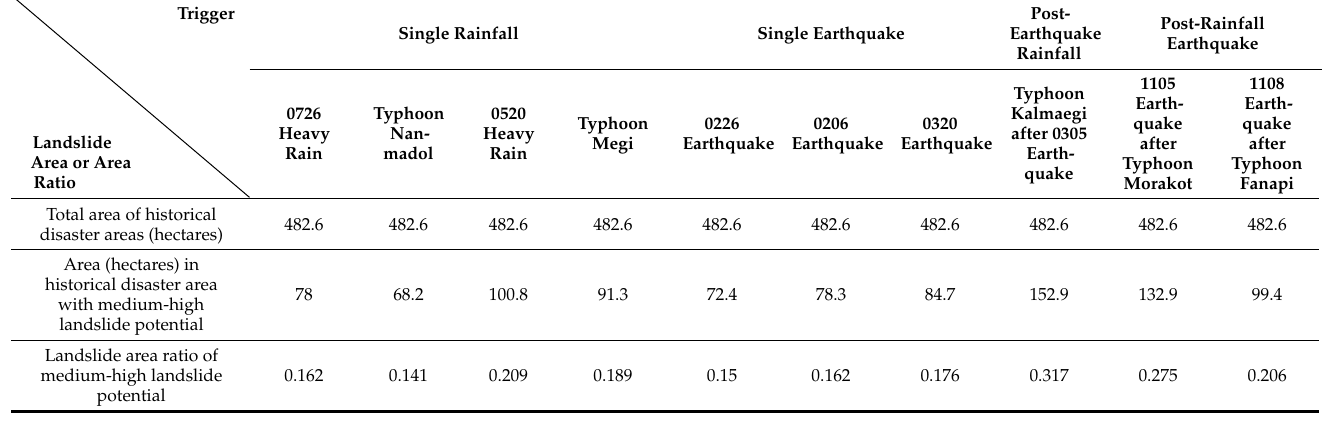
Table 13. Landslide area ratios of medium–high-level landslides induced by rainfall and earthquakes in Dapu Township.